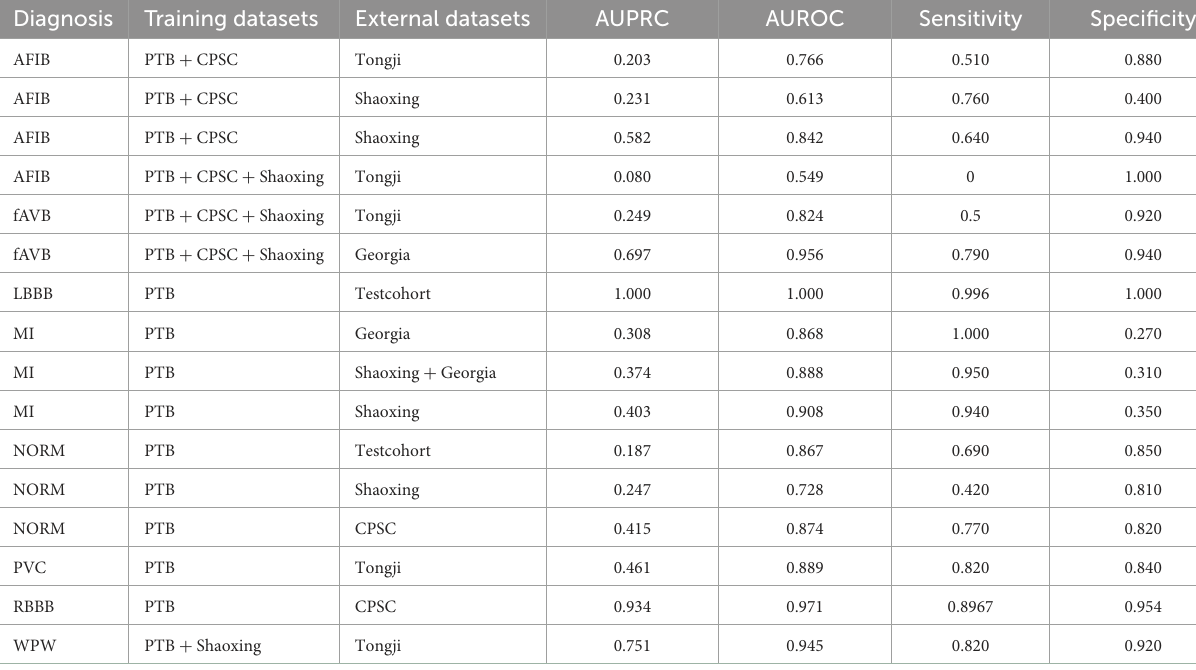
TABLE 4 Test results of models tested on separate, unseen datasets than those used in